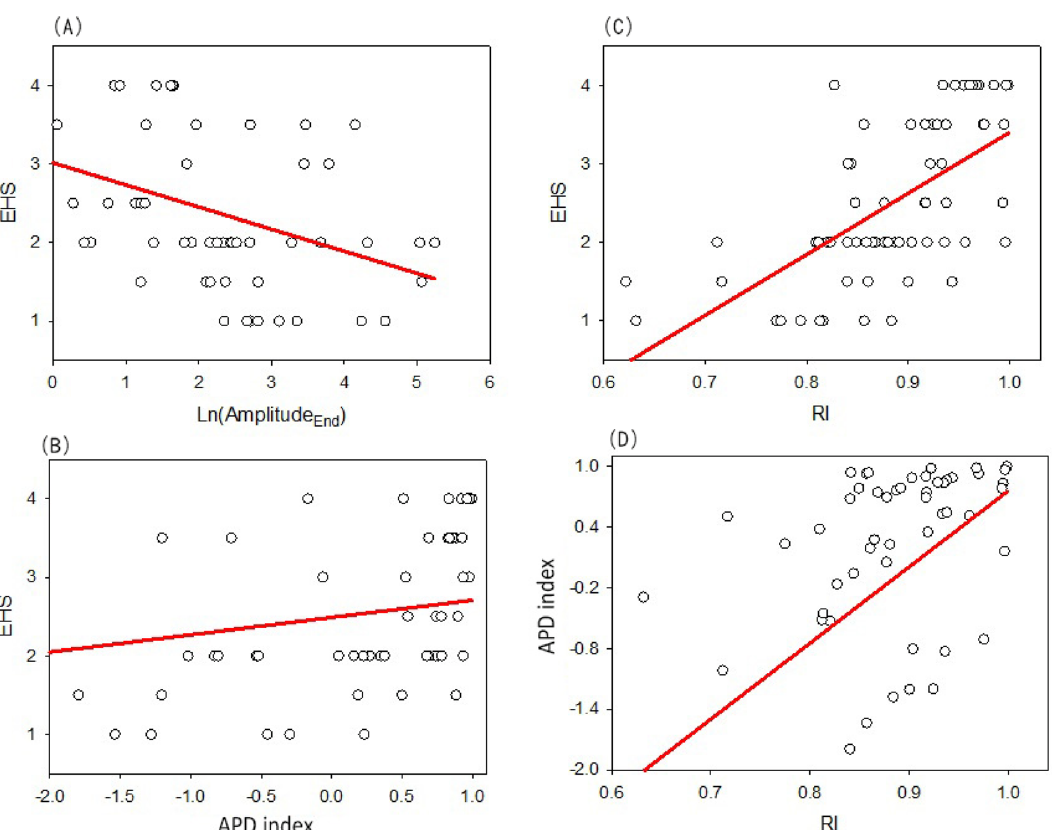
Figure 1. The amplitude correlative series and sexual function. A: Amplitude in the end-erection period is negatively correlated with EHS ( R = − 0.405, p < 0.05); B: APD index is positively correlated with EHS ( R = 0.522, p < 0.05); C: RI is positively correlated with EHS ( R = 0.670, P < 0.001); D: APD index is positively correlated with RI ( R = 0.417, p <